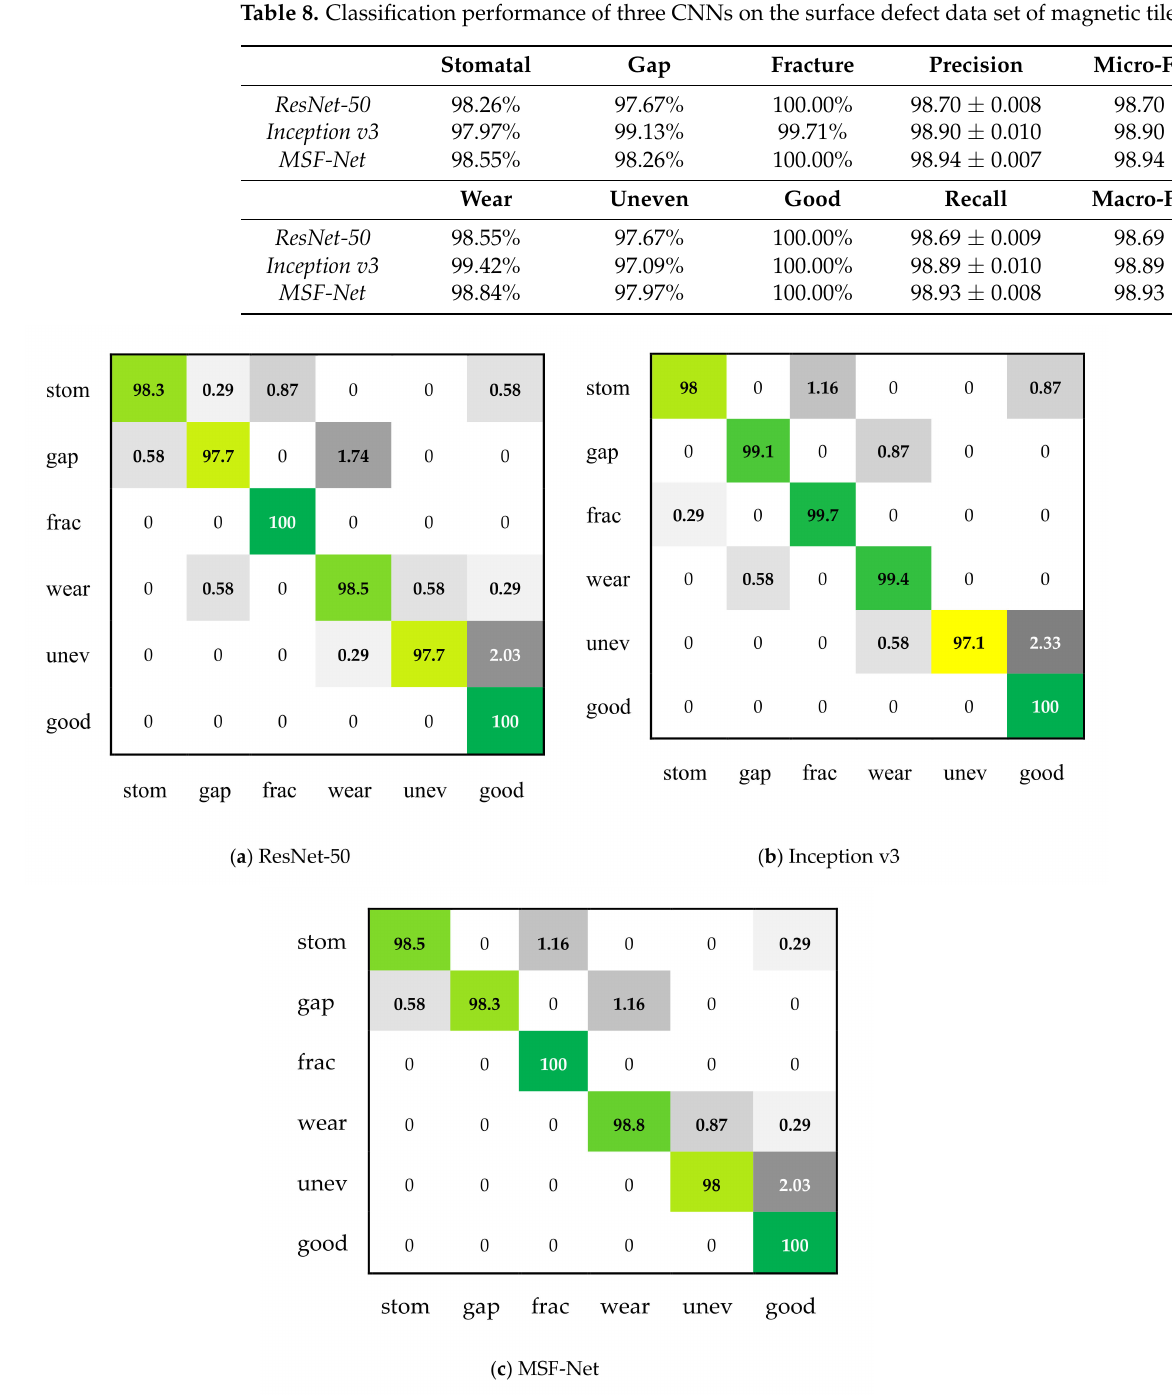
Figure 15. Confusion matrix of three CNNs on the surface defect data set of magnetic tile (Abbreviation description—stom: stomatal; frac: fracture; unev: